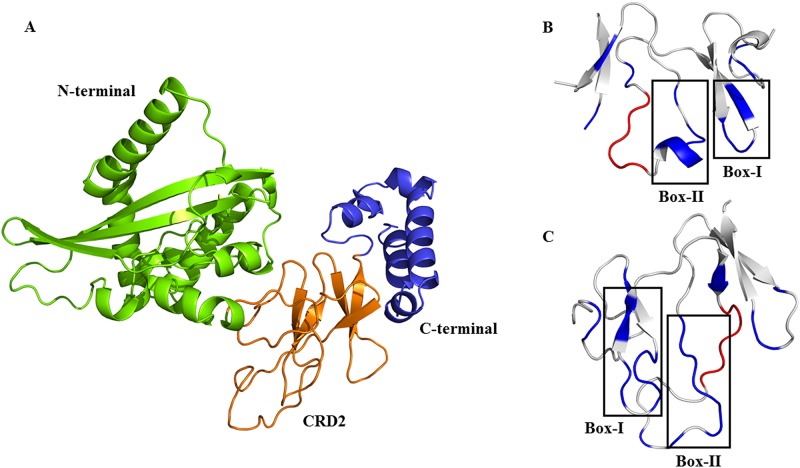
3D structures of whole DKK3 protein along with CRD2 of DKK1 and DKK3.(A) Cartoon representation of 3D structure of DKK3; N-terminal, CRD2 and C-terminal regions are shown in green, orange and blue colors, respectively. (B) The LRP6-binding residues (blue) of CRD2 in DKK1. (C) The LRP6 binding residues of DKK3. A 6-mer box (red) of positively charged residues in CRD2 of DKK1 has an important role in DKK1-LRP6 interactions, while this site in CRD2 of DKK3 (red) has considerably changed with several non-conservative substitutions and has no role in DKK3C-LRP6 interactions.